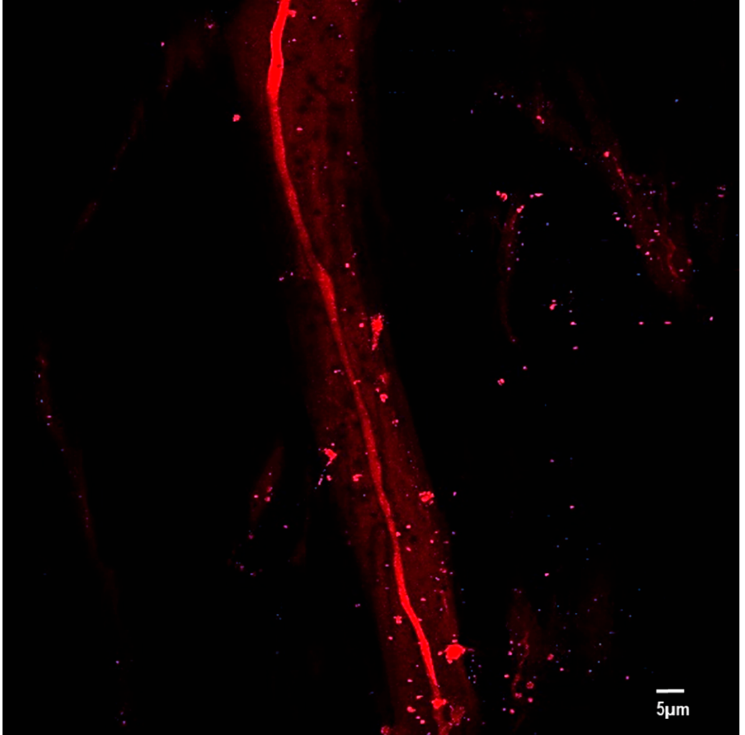
Figure 5. he SHG microscopy image of electrospun PBLG/PVDF fibers. The main red fiber is the core PBLG with a highly oriented dipole moment. The blurred red region is partially PVDF and/or a small amount of PBLG.